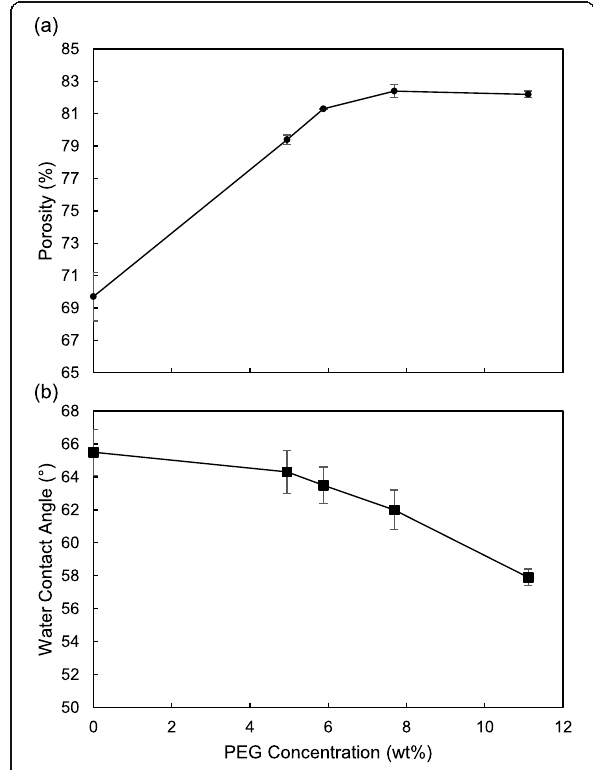
Fig. 5 a Porosity of the PET membranes as a function of PEG 400 concentration, ( b ) Water contact angle of the PET membranes as a function of PEG 400 concentration